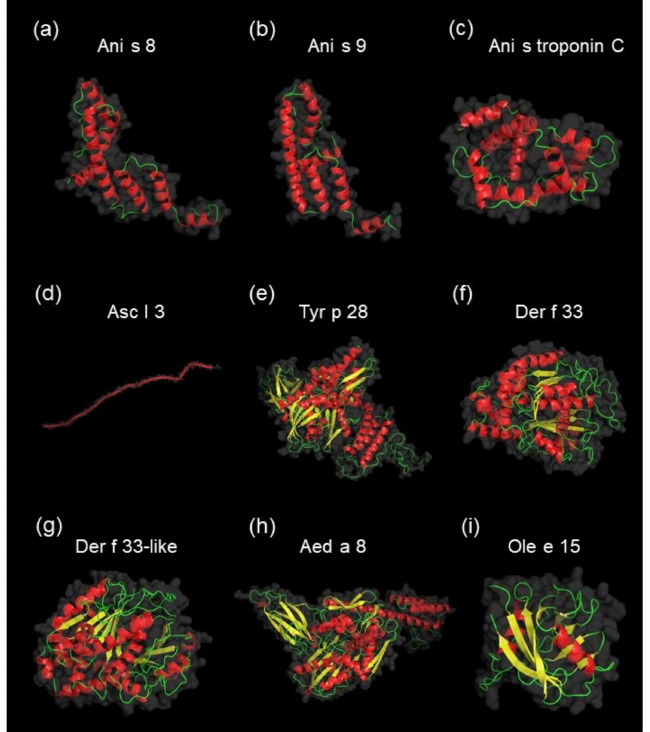
Figure 6. The native tertiary structures of homologous allergens, as identified using AllergenOnline.org for potential allergens of A. simplex . Prediction of unknown 3D structures of allergens: Ani s 8 (85% of residues modeled at > 90% confidence, model dimensions in angstroms (Å): X: 62.875 Y: 60.531 Z: 35.486) ( a ), Ani s 9 (87% of residues modeled at > 90% confidence, model dimensions in Å: X:54.278 Y: 58.349 Z:28.680) ( b ), Ani s troponin C (99% of residues modeled at > 90% confidence, model dimensions in Å: X:50.390 Y: 40.831 Z:35.415) ( c ), Asc l 3 (99% of residues modeled at > 90% confidence, model dimensions in Å: X:361.607 Y:132.976 Z:152.396) ( d ), Tyr p 28 (97% of residues modeled at > 90%